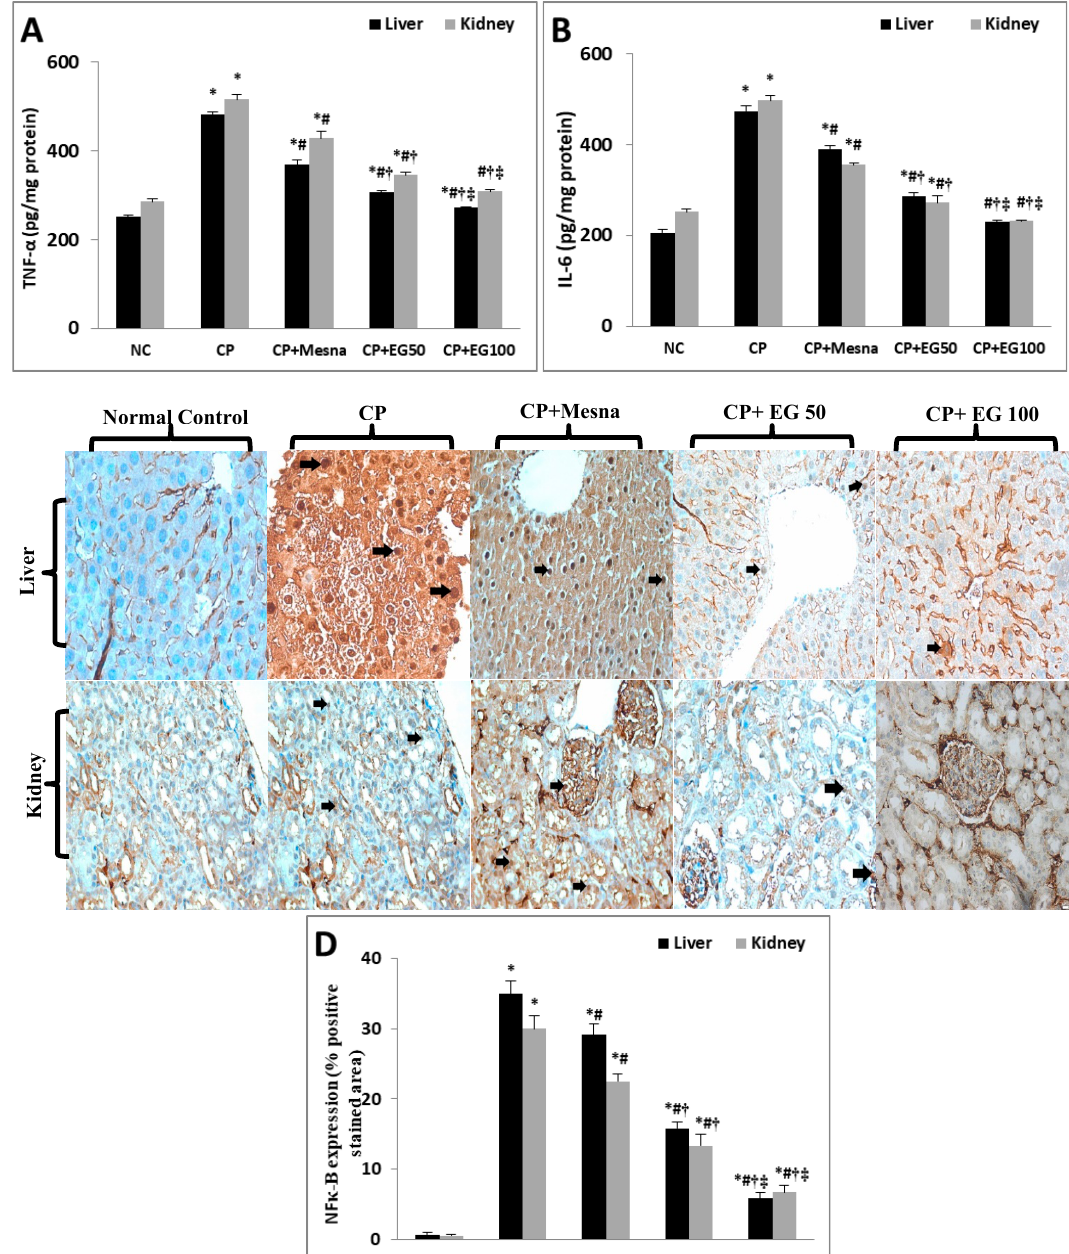
Figure 5. Effect of EG pretreatment on liver and kidney levels of pro-inflammatory markers (TNF- α ( A ), IL-6 ( B )), IHC expression of NF- κ B ( × 400, black arrows represent localization of positively stained brown nuclei with faint ignored background staining) ( C ) and semi-quantitative estimation of NF- κ B positively stained nuclei in hepatic and renal tissues of CP-treated mice.